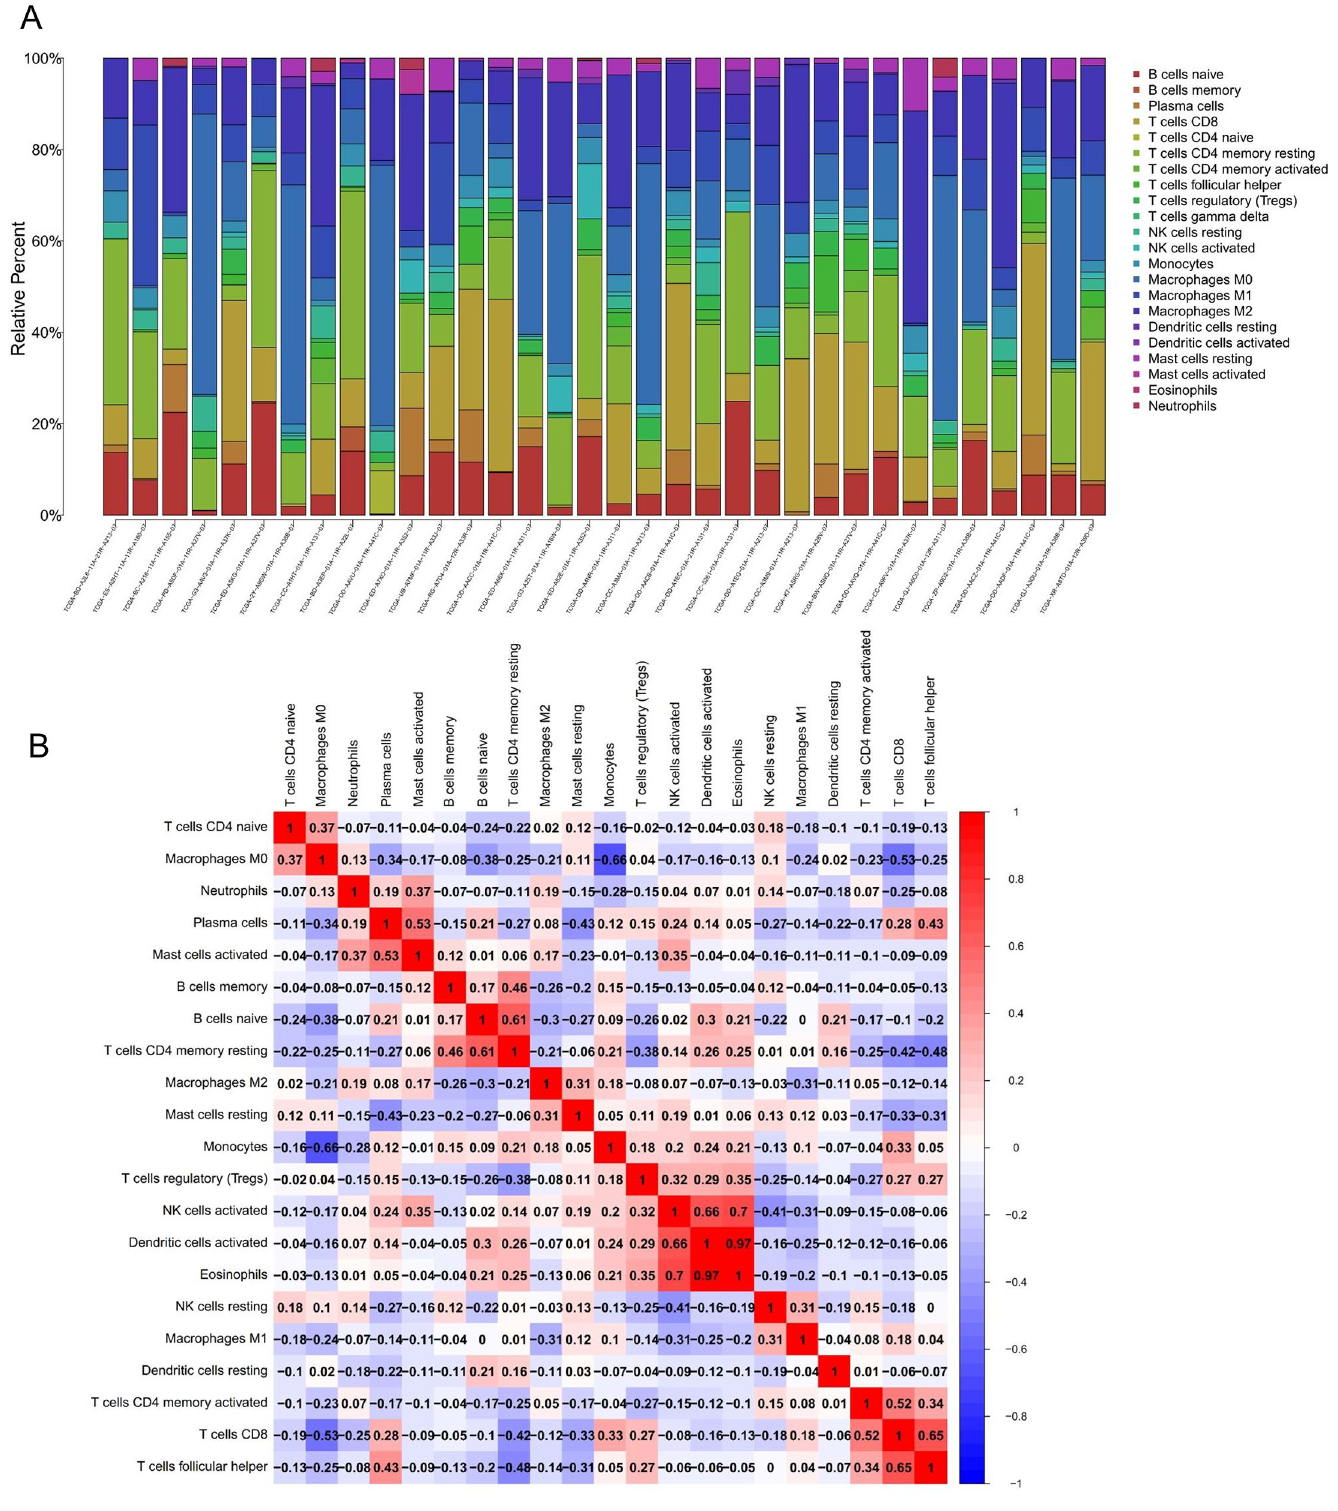
Fig 8. The immune - cell infiltration was assessed by CIBERSORT algorithm in hepatocellular carcinoma. (A) The composition ratio of 22 immune cell types. (B) Correlation matrix between the 22 immune cell types.